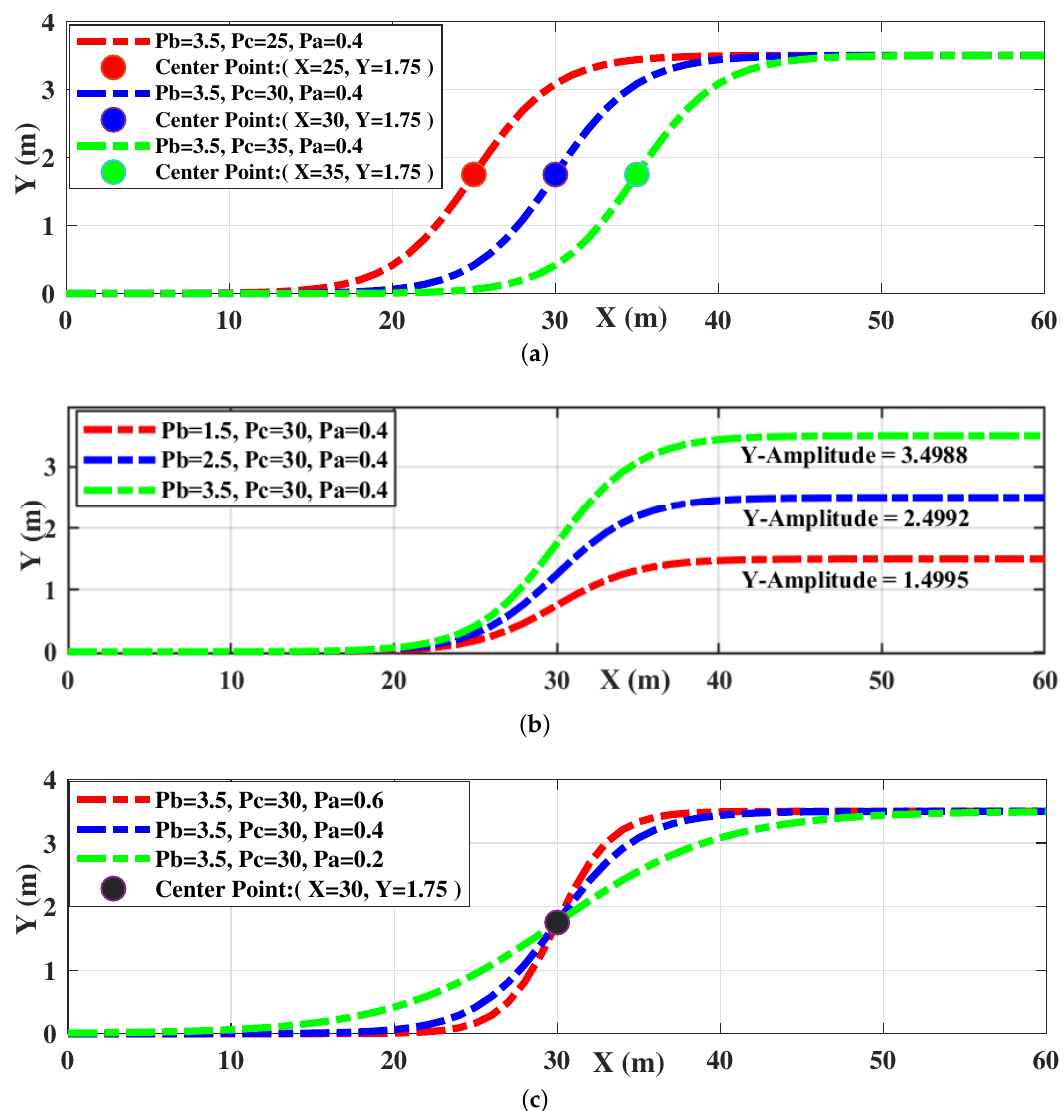
Figure 7. Tunable features of the sigmoid curve: ( a ) Sigmoid curves with different central point; ( b ) Sigmoid curves with different central point; ( c ) Sigmoid curves with different maximum